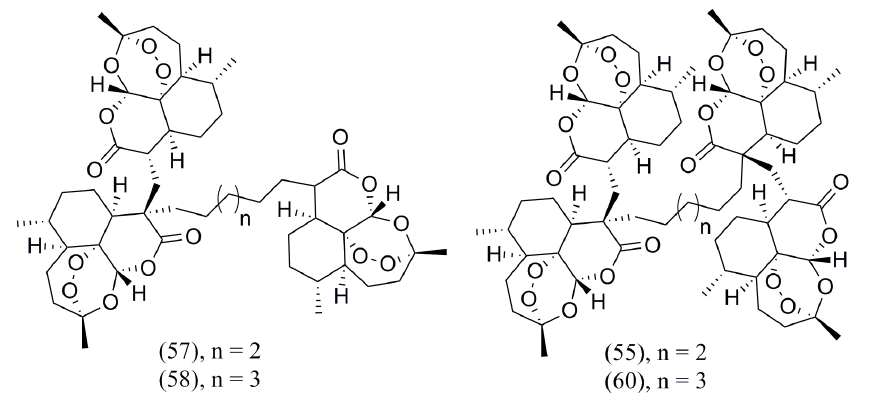
Figure 18 - Structures of ART trimer 57 and 58 and tetramer 59 and 60